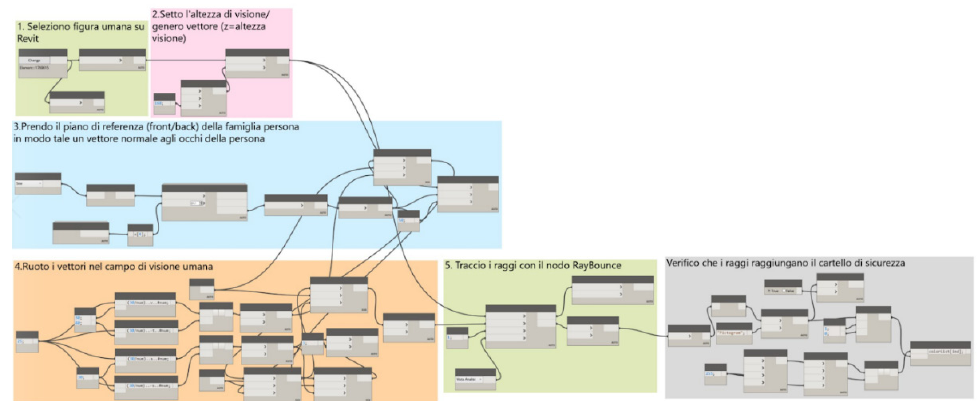
Figure 11. Simulation of different types of users in an exhibition space. On the first row, a graphic map of the paths; below, a graphic map of the dynamic density.